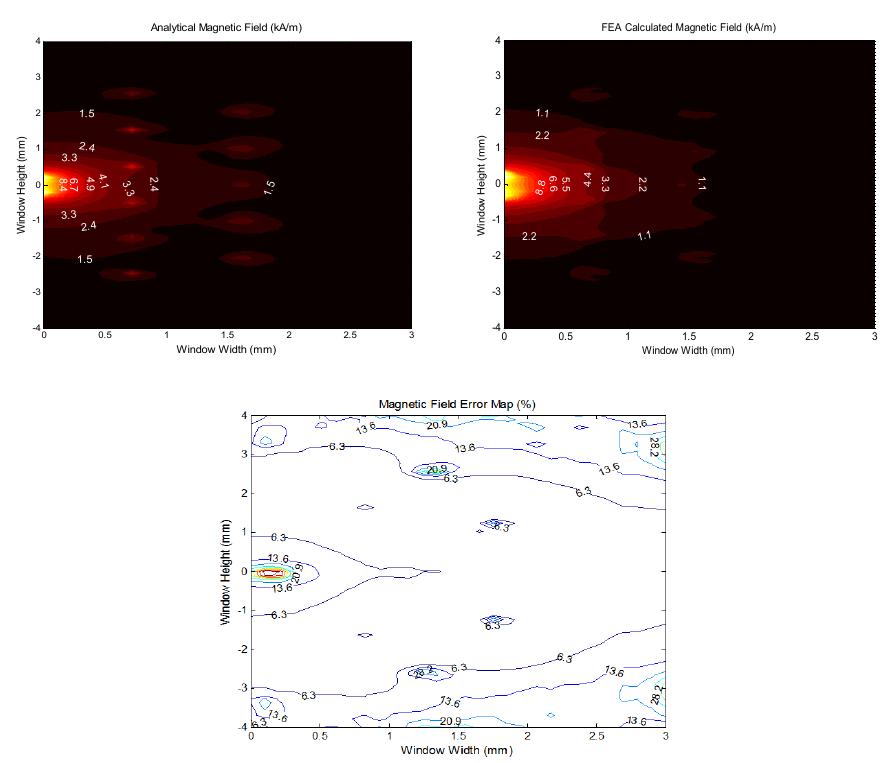
Figure 8. Analytical and numerical contour plot of the magnetic field for the inductor in Figure 7.